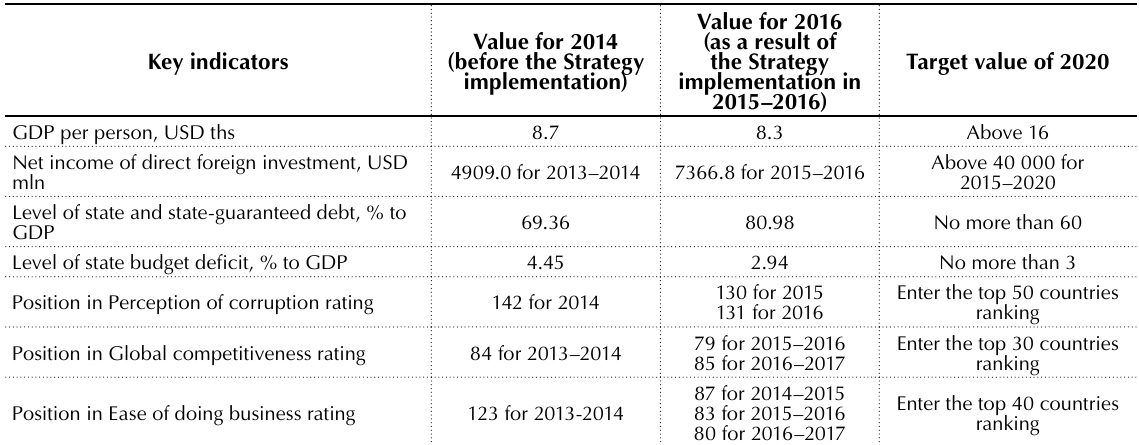
Table 12. Preliminary results of the National Security Strategy implementation according to main